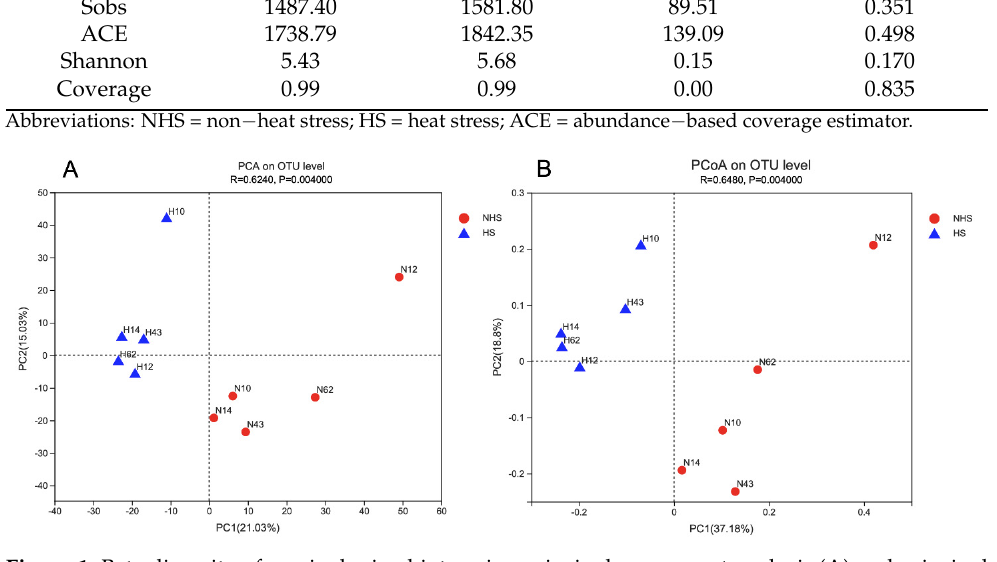
Figure 1. Beta diversity of ruminal microbiota using principal component analysis ( A ) and principal co-ordinates analysis ( B ). NHS, non-heat stress condition; HS, heat stress condition. Ruminal bacterial community composition and structure were analyzed at different taxonomical levels. At the phylum level (Figure 2A), most sequences were assigned to